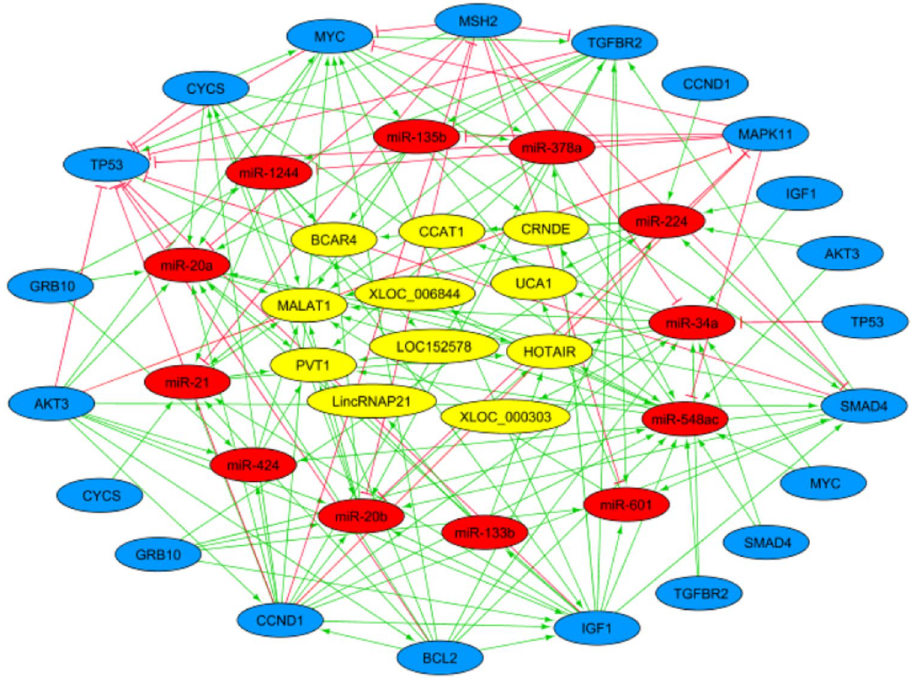
Figure 4. The lncRNA–miRNA–mRNA network. The network includes 44 nodes and 153 edges. The yellow, red, and blue ellipses represent the lncRNAs, miRs, and genes, respectively.